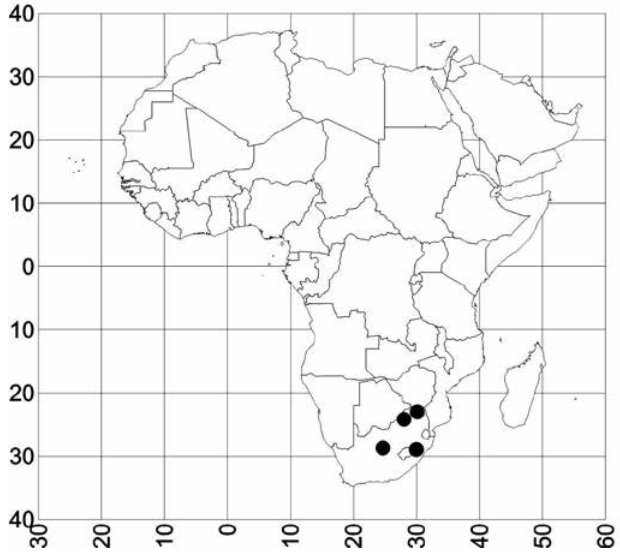
Map 10 . The distribution of B. strigulosa